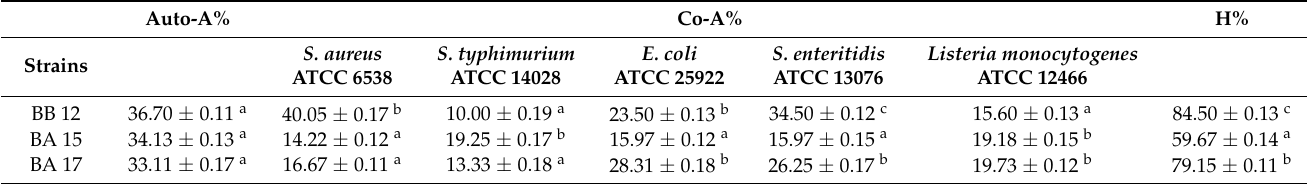
Table 7. Auto-Aggregation, Co-Aggregation and Hydrophobicity Abilities of the tested